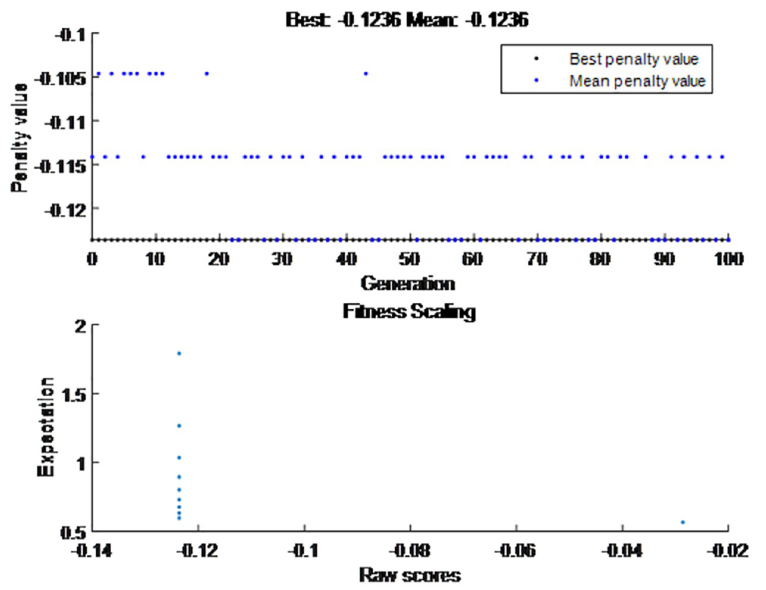
Fig 6. Evolutionary curve of genetic